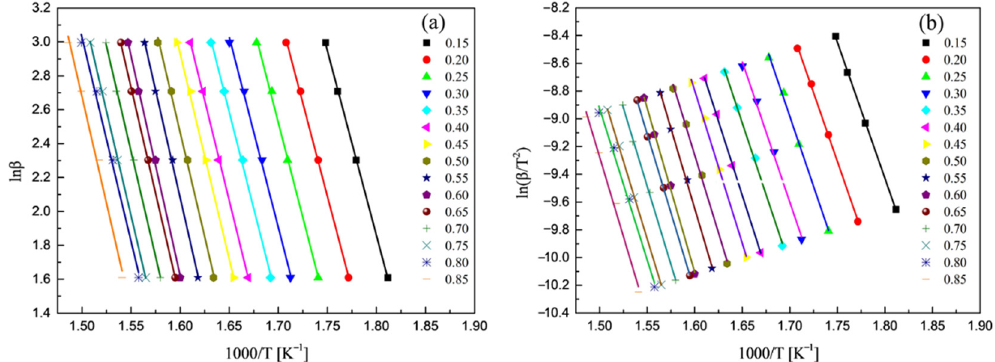
Figure 3. ( a ) FWO and ( b ) KAS plots of pine sawdust at different conversion rates. The fitting results show a better linear correlation, with R 2 > 0.99 (Figure 3). The corresponding apparent activation energy at different conversion rates was calculated by using the slope of the fitting curves obtained by the FWO and KAS methods. Table 2 summarizes the calculated results. The E values continuously change with the increase in the conversion rates, and the difference between the minimum and maximum E values is ≈ 35 kJ/mol. Owing to the complexity of the biomass components, thermal degradation involves multi-step kinetics with different apparent activation energies [50]. Given a conversion value then the E value calculated by the iso-conversional method is similar. The values are 180.91 kJ/mol and 188.52 kJ/mol, respectively. Thus, the average value from KAS and FWO is considered as the estimated activation energy for the pyrolysis of biomass, which is 184.72 kJ/mol. The activation energy for devolatilization (pyrolysis) has been mainly examined under Ar. Wang et al. [30] have reported an apparent activation energy of 221.7 kJ/mol at heating rates of 10, 20, and 30 ◦ C/min for the thermal decomposition of an agricultural residue. Özsin et al. [51] have reported E values for the pyrolysis of chestnut shells, cherry stones, and grape seeds using the KAS method at heating rates of 5, 10, 20, and 40 ◦ C/min. They obtained average values of 175.2, 272.2, and 186.6 kJ/mol, respectively. Damartzis et al. [26] have reported E values for the thermal degradation of cardoon leaves using independent parallel reaction model at heating rates of 5, 10, 20, and 30 ◦ C/min. They found that the highest E values for the decomposition of hemicellulose and cellulose range from 52 to 181 kJ/mol and from 73 to 95 kJ/mol, respectively, while the lowest E value is obtained for the decomposition of lignin (29–50 kJ/mol). Kok et al. [52] have reported E values for miscanthus, poplar wood, and rice husk using the FWO method at five heating rates of 5, 10, 15, 25, and 50 ◦ C/min, respectively, at 20–600 ◦ C. Their corresponding values are 229.4, 219.2, and 250.3 kJ/mol. Gu et al. [53] have determined the E values for the pyrolysis of poplar wood and sawdust using the Kissinger and FWO methods at different heating rates of 10, 20, 40, and 80 ◦ C/min up to 1000 ◦ C. The E values range from 134 kJ/mol to 142 kJ/mol. The calculated E values exhibit a minor difference compared to previous studies that utilize a myriad of methods to determine E , related to the reaction atmosphere and heating rates.